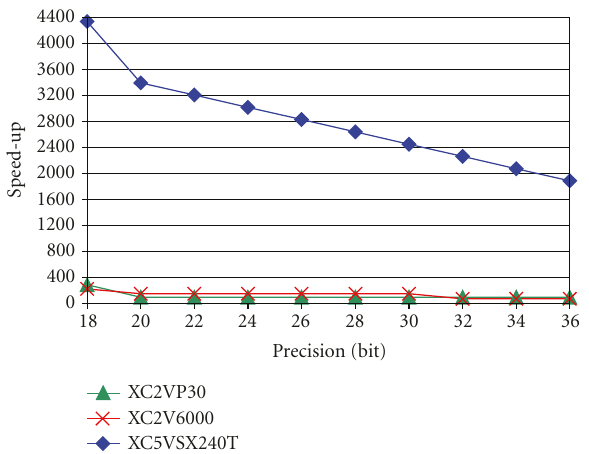
Figure 11: Performance of di ff erent implementations compared to an Intel Core2 Duo processor running on 2GHz.